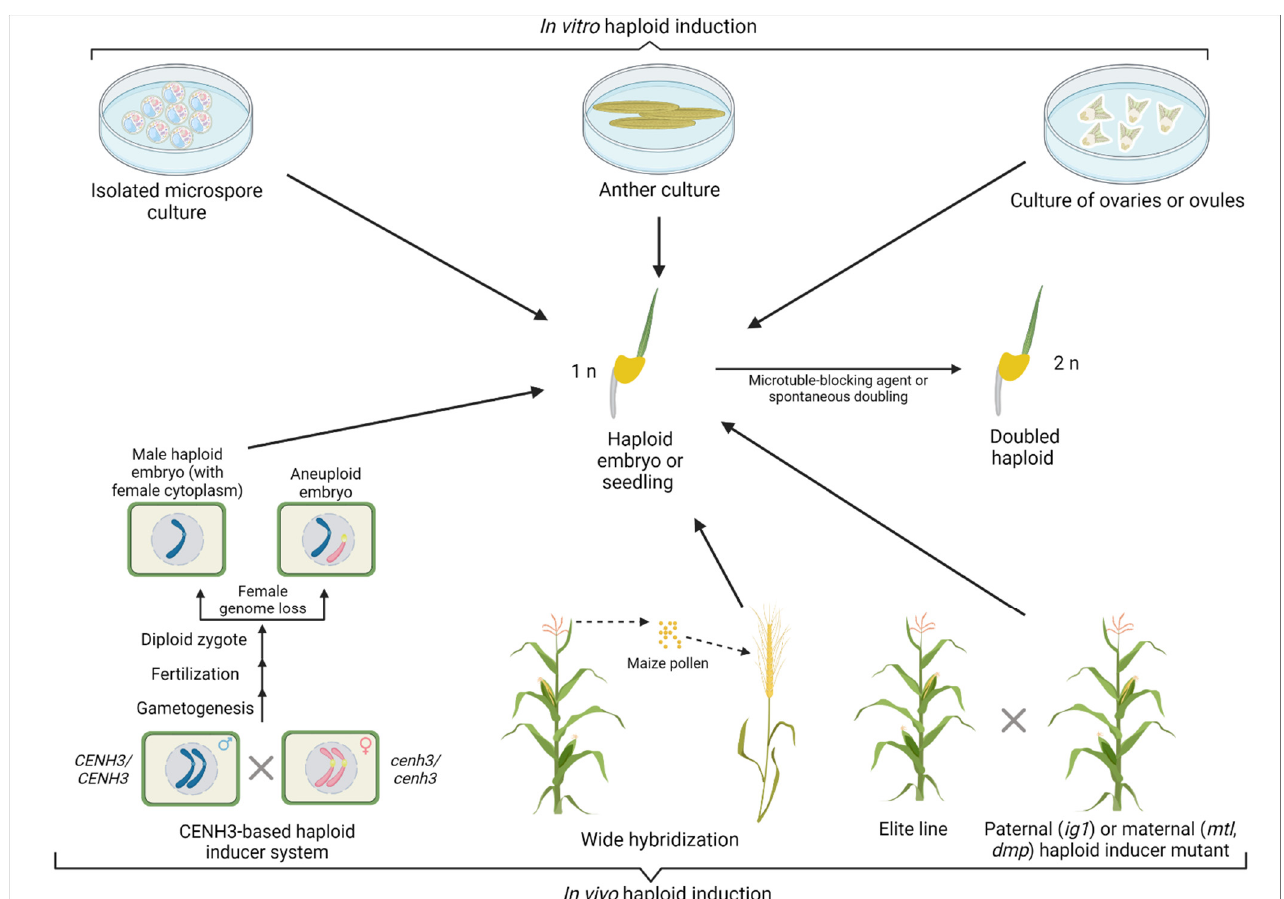
Figure 1. Summary of haploid induction (HI) methods. Haploids can be induced through in vitro and in vivo methods. Whereas the in vitro methods include isolated microspore culture, as well as anther and ovary/ovule culture, current in vivo methods are based on CENH3 -mediated induction, wide hybridization techniques, and haploid inducer mutants. CENH3 —centromere histone H3, MTL — MATRILINEAL , DMP —DOMAIN OF UNKNOWN FUNCTION 679 membrane protein, ig1—indeterminate gametophyte 1 . Created with BioRender.com (website: https://biorender.com/, accessed on 29 July 2021).